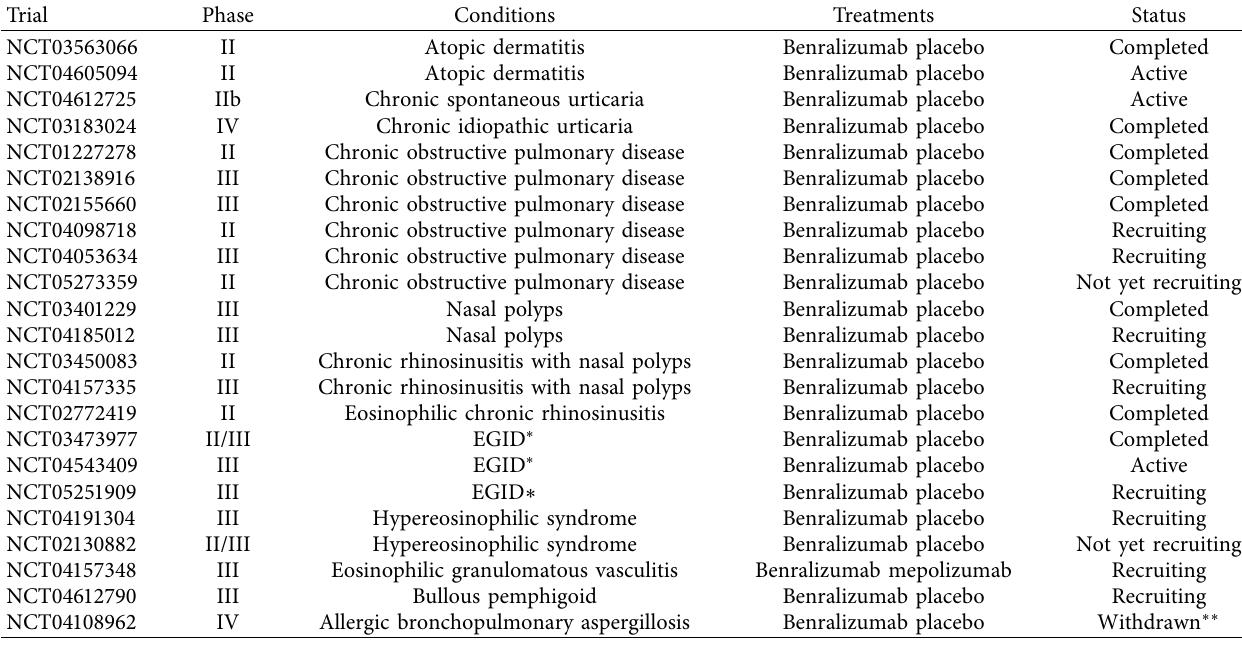
Table 1: Main ongoing clinical trials with benralizumab.